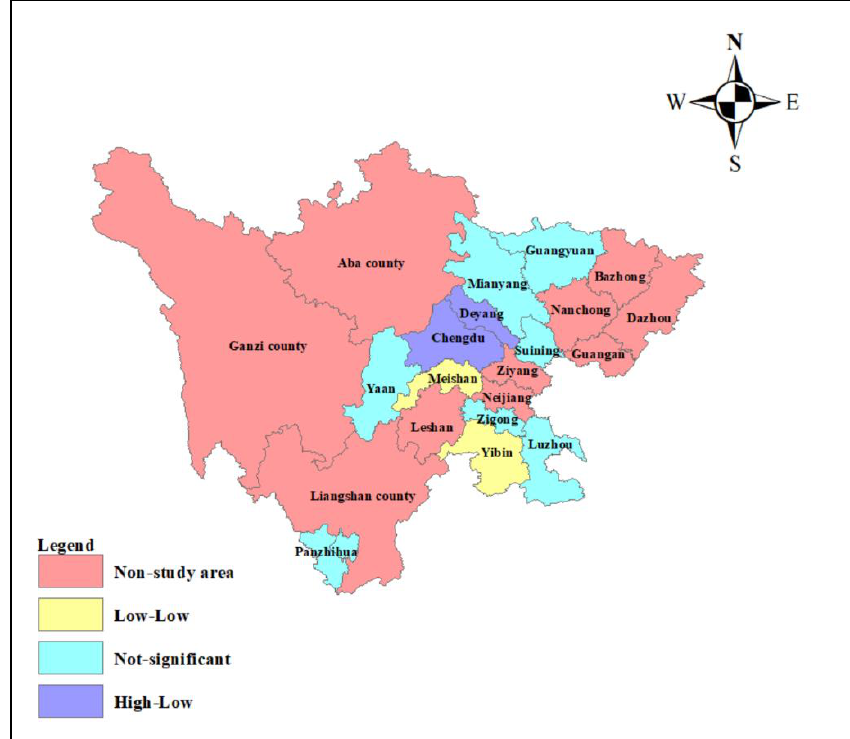
Figure 12. LISA aggregation diagram of the 11 counties’ CGLUE in 2010.